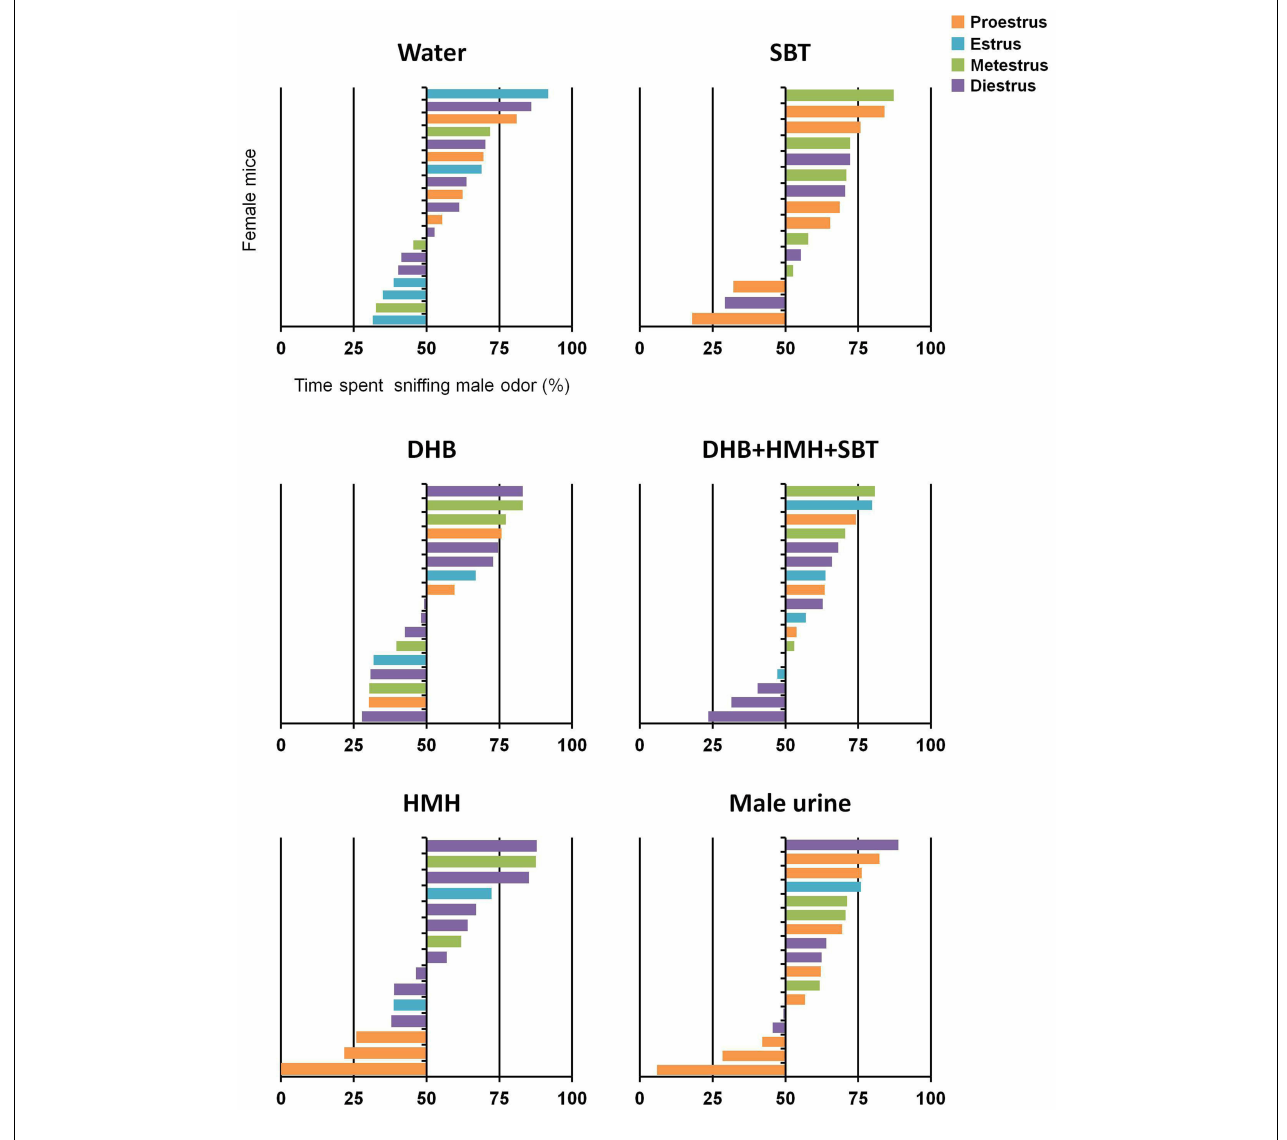
FIGURE 4 | Male-directed odor preference according estrous cycle stage. Percentage of time spent sniffing male odor compared to total time spent sniffing both male and female odors at PD45 by each female Swiss mice in each group (water, DHB,